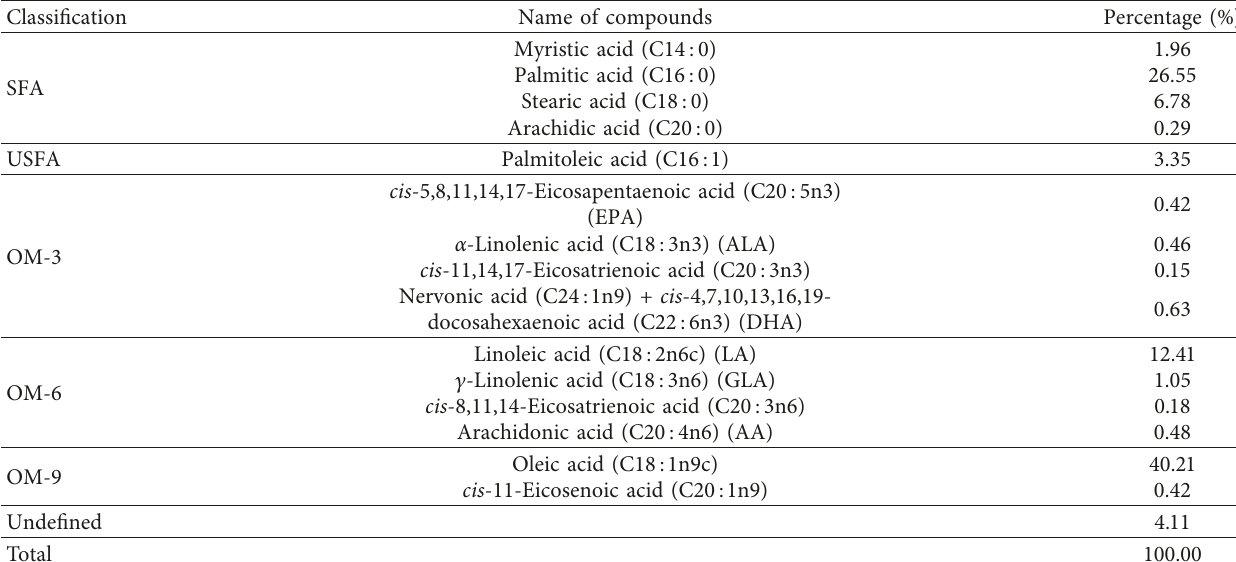
Table 4: Classification of saturated fatty acids, unsaturated fatty acids, and omega in methyl